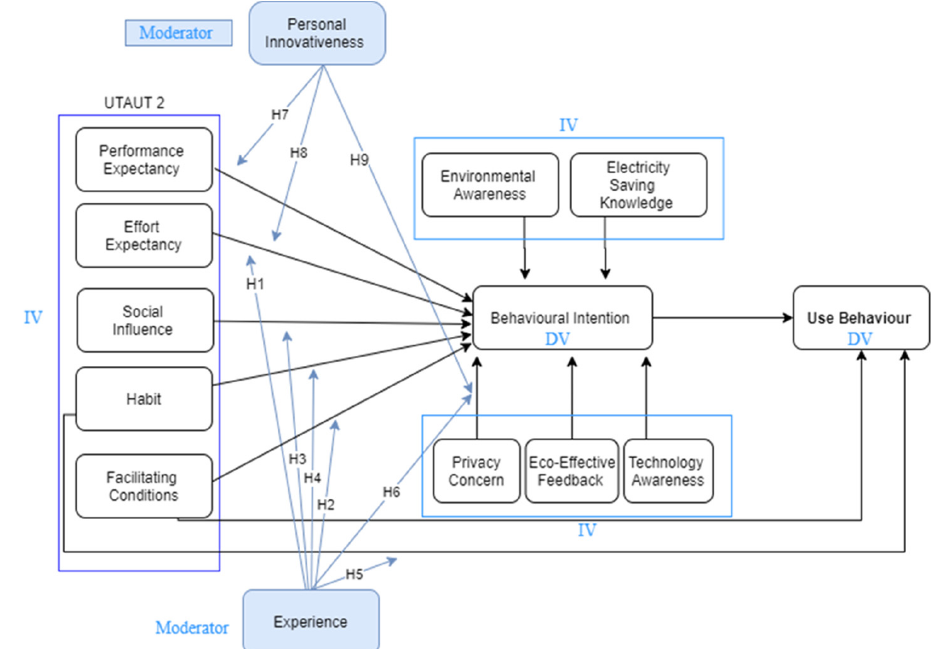
Figure 1. Research model.